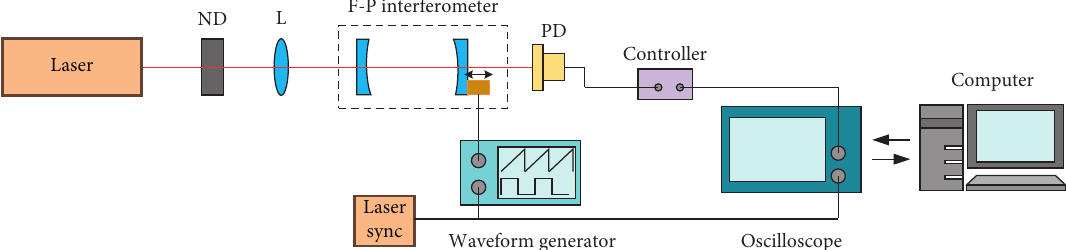
Figure 2: Schematics for scanning F-P interferometer method used in laser linewidth measurement.